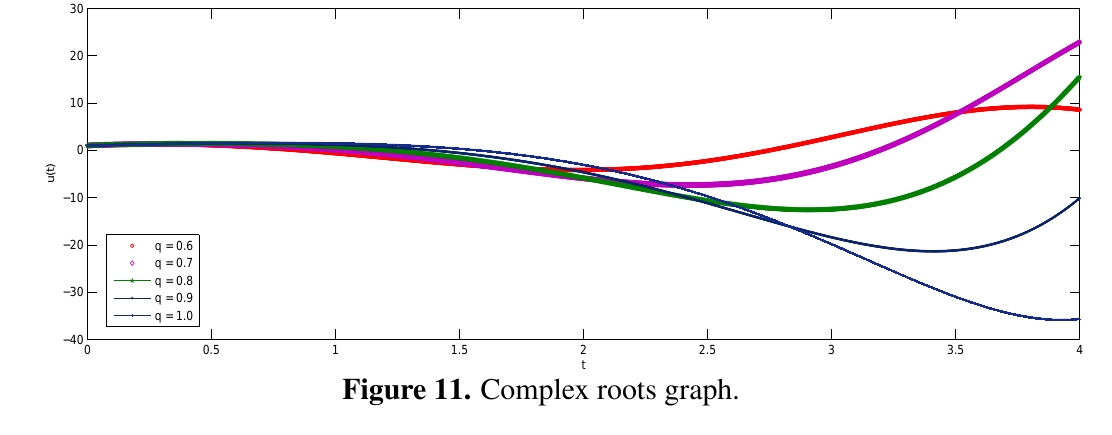
Figure 11. Complex roots